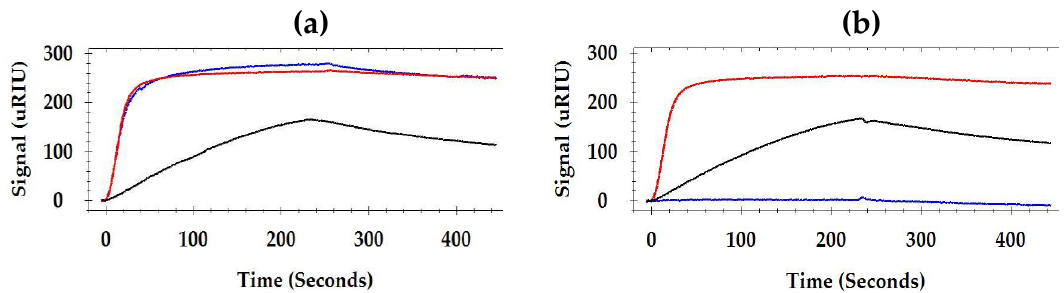
Figure 3. Representative SPR sensorgrams showing ( a ) non-inhibition and ( b ) inhibition of the binding of a pair of monoclonal antibodies; ( a ) Flagellin (black curve) was captured by MAb 1E10 immobilized on the surface. Immediately after the flagellin, MAb 1C8 (red curve) was injected and MAb 3H8 (blue curve) was followed after. Both MAbs (1C8 and 3H8) produced binding curves (non-inhibition); ( b ) Flagellin (black curve) was captured by MAb 1E10 immobilized on the surface. Immediately after the flagellin, MAb 1C8 (red curve) was injected and MAb 7E3 (blue curve) was followed after. MAb 7E3 failed to produce a binding curve (inhibition).